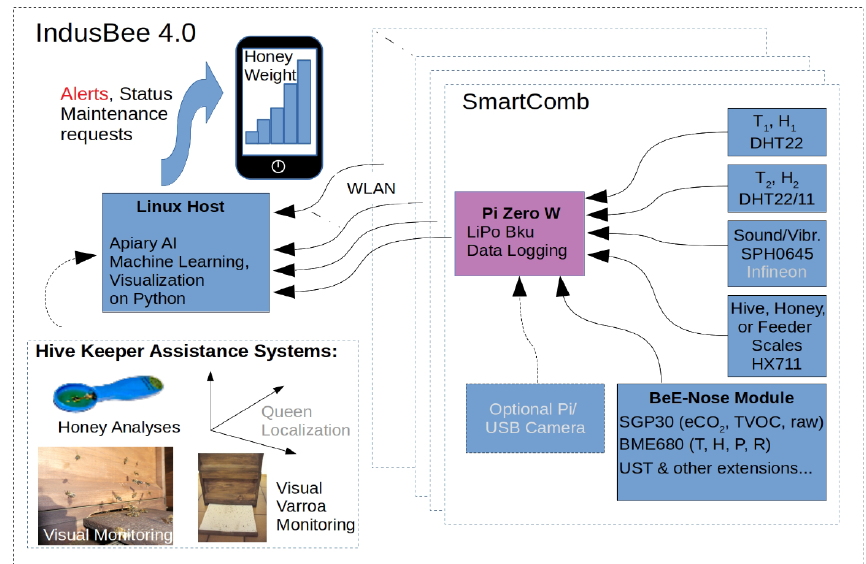
Figure 1. Overview of the IndusBee4.0 apiary monitoring system with SmartComb units including BeE-Nose for VILE (adapted from König,